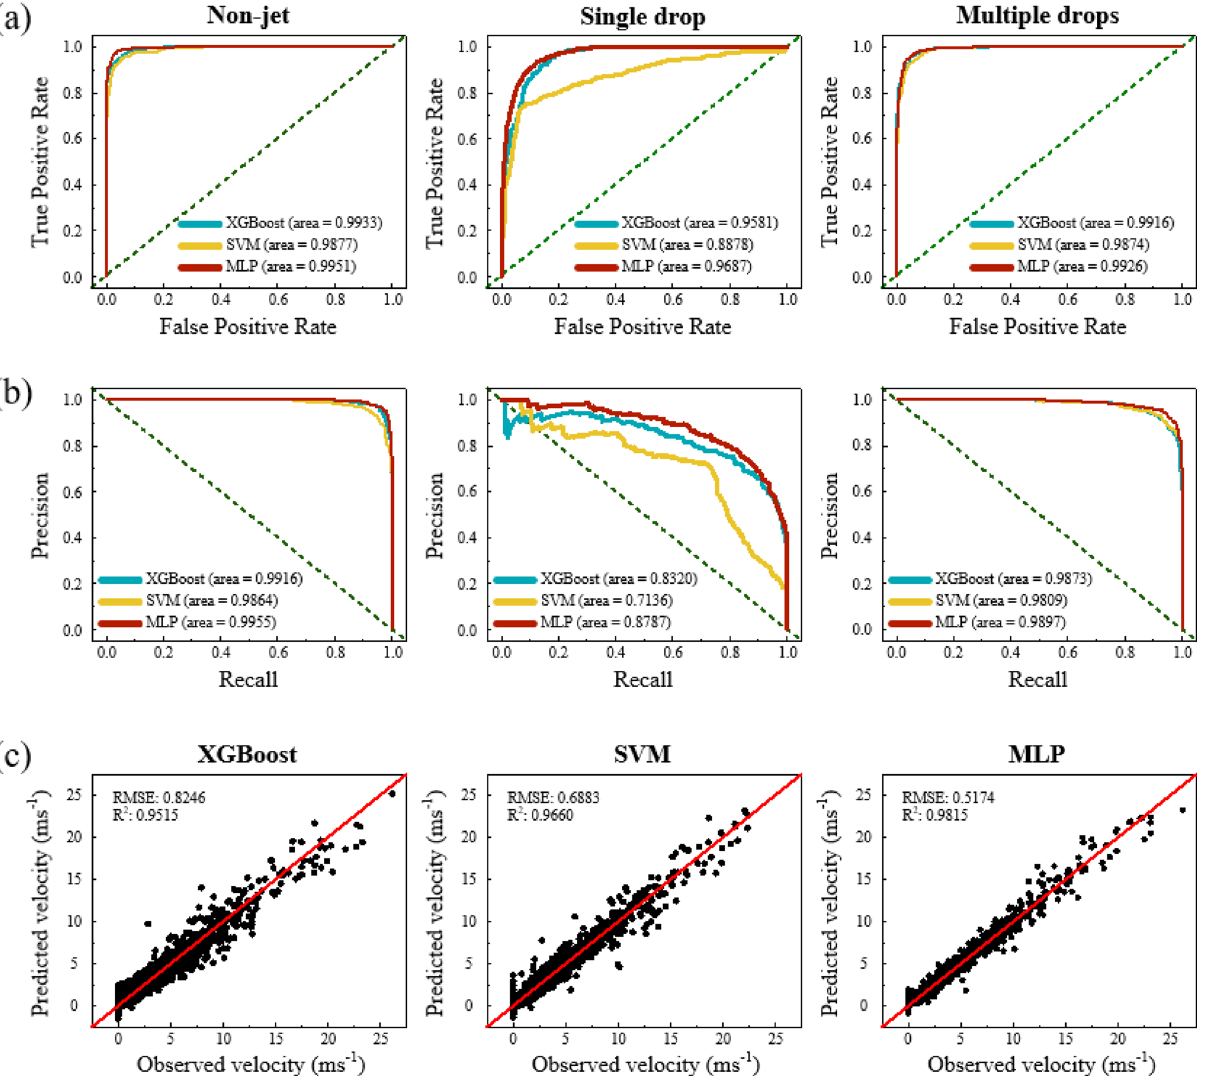
Figure 4. ( a ) Receiver operating characteristic curve and ( b ) precision-recall curve of predicting drop formation applying the test set in SVM, XGBoost, and MLP models. ( c ) Comparison of observed and predicted drop velocity using XGBoost, SVM, and MLP in the test set. The green dash line indicates the randomly guessing baseline.